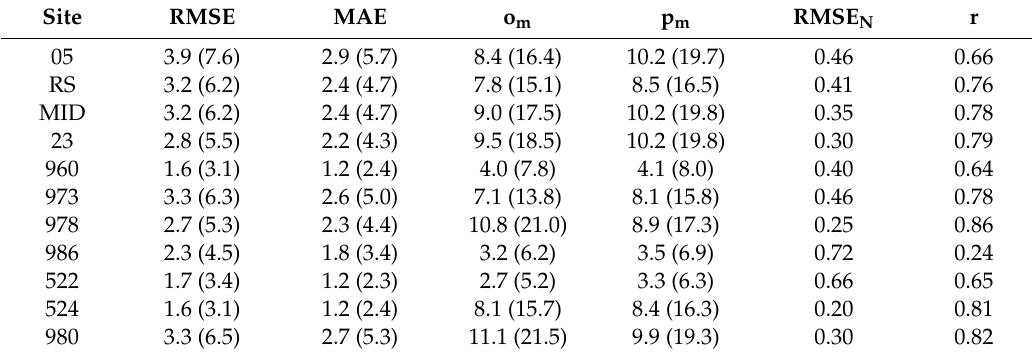
Table 3. Skill scores of hourly forecasts for wind gust at di ff erent locations of the Madeira Island (see locations in Figure 1a). The values of root-mean-squared error (RMSE), mean absolute error (MAE), average values of observations (o m ) and forecasts (p m ) are displayed in m s − 1 and kt (in parenthesis). The normalized RMSE (RMSE N ), defined as RMSE / o m , and the correlation coe ffi cient, r, are also